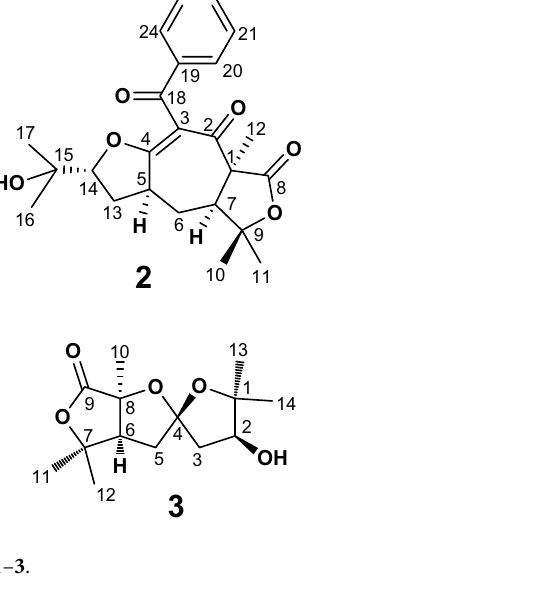
Figure 1. Structures of compounds 1 – 3